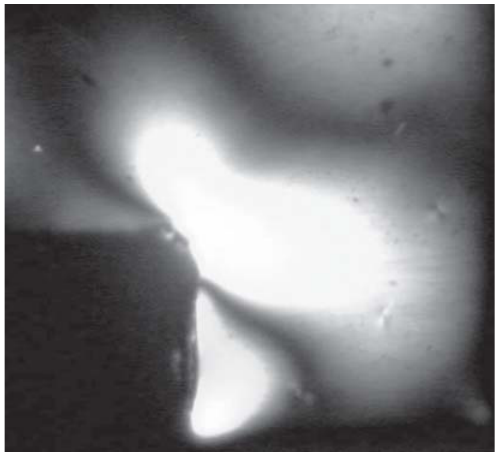
FIGURE 3- Stress area recorded in black field for determination the contraction stress